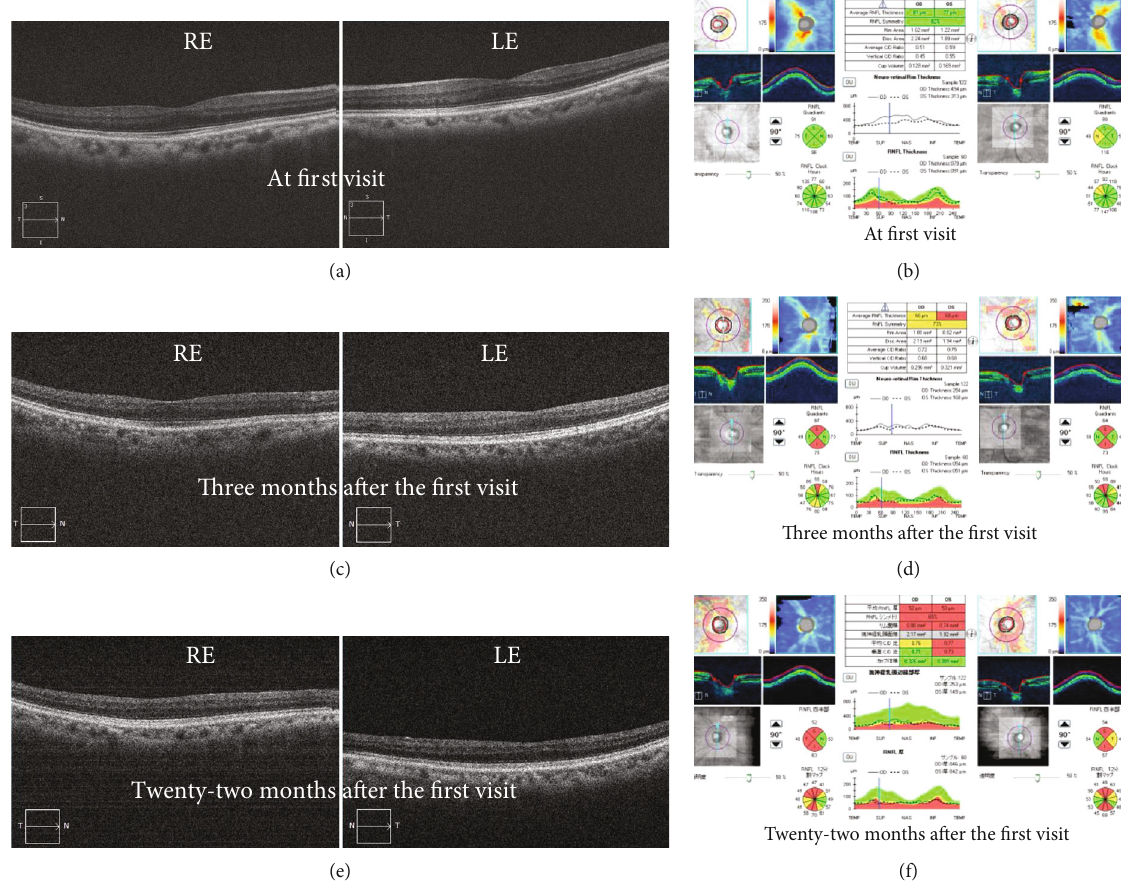
Figure 3: Optical coherence tomography (OCT) imaging. At the fi rst visit, OCT revealed no remarkable fi ndings on the macula and optic discs in both eyes (a, b). However, the macula (c, e) and optic disc head (d, f) had thinned in both eyes during the clinical